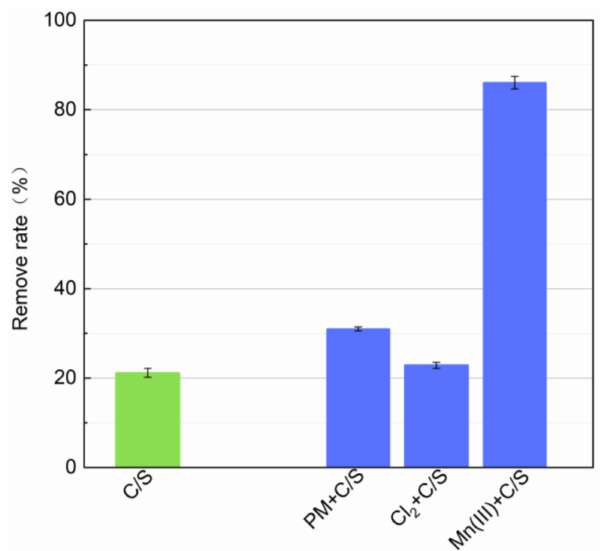
Figure 4. Removal e ffi ciency of Nano-ZnO by C / S and C / S enhanced with Mn(III) pre-oxidation, KMnO 4 pre-oxidation, and chlorine pre-oxidation.